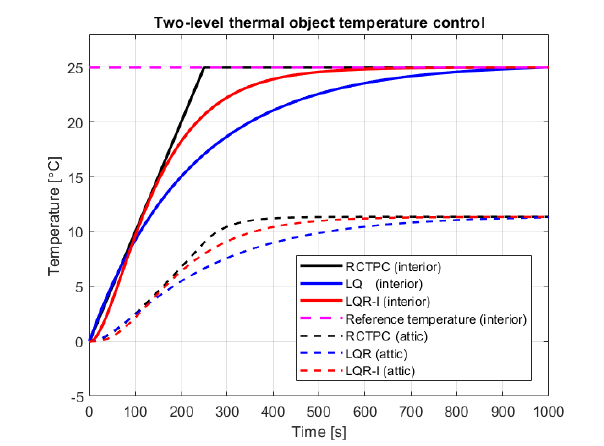
Figure 5. Interior temperature control (source: authors).